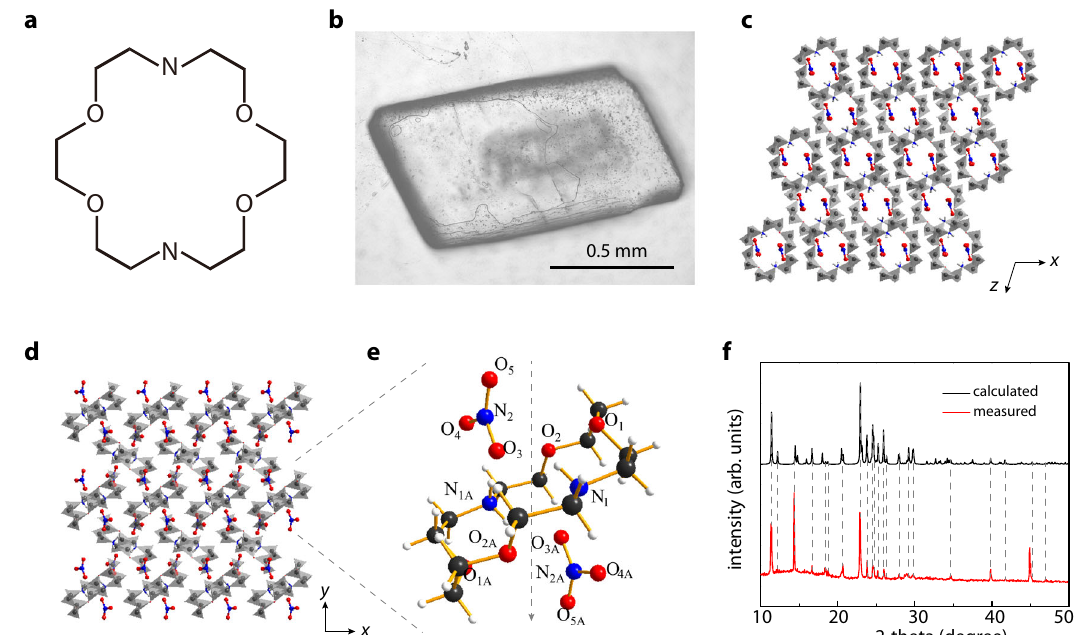
Fig. 1 Synthesized crown-ether-based porous crystal. a Structure of the chosen crown ether, 1,10-diaza-18-crown-6-ether (DA18C6). b Picture of a synthesized DA18C6-nitrate single crystal. c , d Crystal structure viewed down [010] ( c ) and [001] ( d ) directions. In the [010] direction, the DA18C6 rings form densely packed subnanometer channels, allowing the transport of ions. The other two directions do not allow ion transport. e Magni fi ed view of ( d ) and expected ion transport path (dashed line). Detailed crystal structure information can be found in the Supplementary information. Blue: nitrogen. Red: oxygen. Gray: carbon. f To verify the structure, we calculated theoretical powder X-ray diffraction pattern of the crystal, and measured the experimental one, whose results are in good